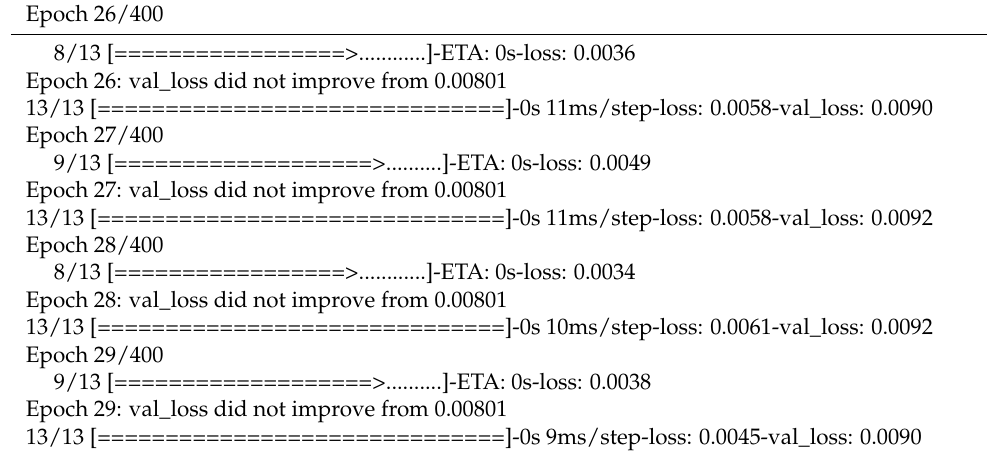
Table 3. The model is trained to access only the most specific outcomes. Epoch 26/400